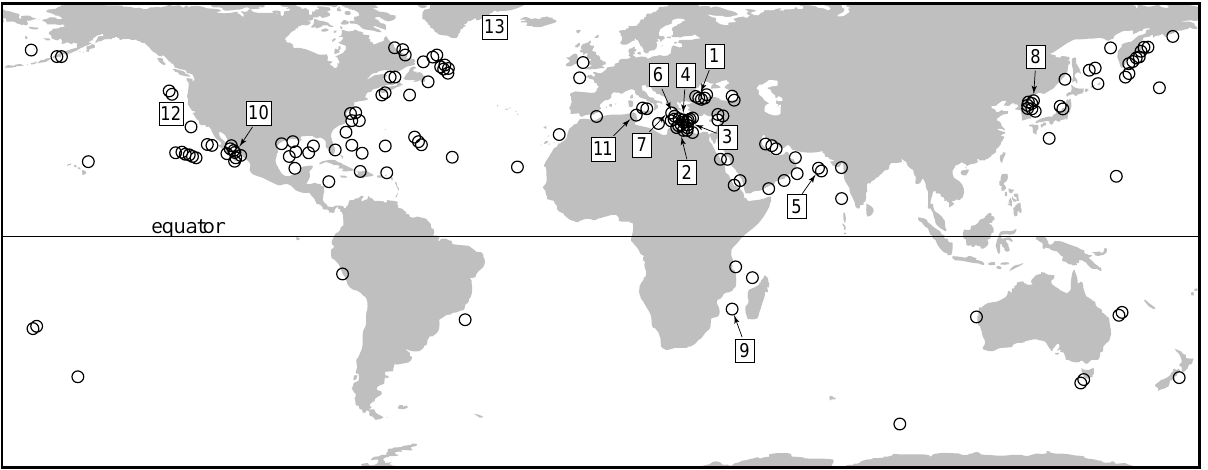
AMBIENT OCEAN VORTICITY Measurement of surface velocity shear du/dy along 1000 km of roughly northward track in the North Pacific (Rudnick and Ferrari, 1999) indicate values of order 10 -5 s -1 . The situation is conveniently portrayed by a distribution of Rossby Numbers Ro = z /